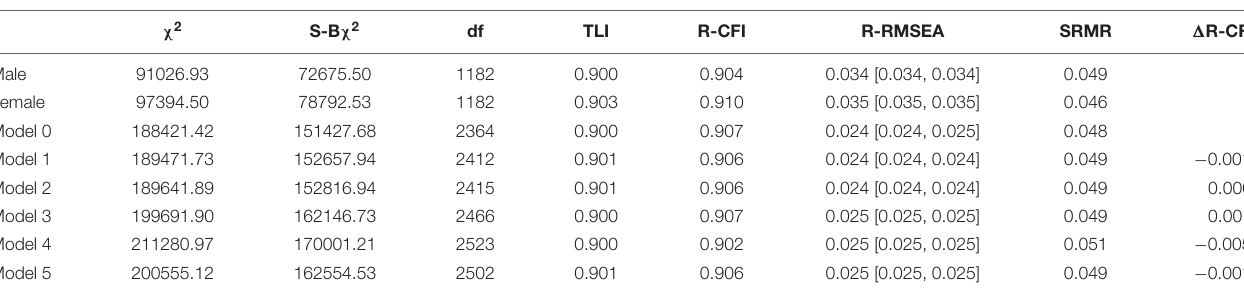
( Table 6 ). Goodness-of-fit was less strong for African-American (R-RMSEA = 0.034, 90% confidence interval: 0.34–0.35; (R-RMSEA = 0.036, 90% confidence interval: